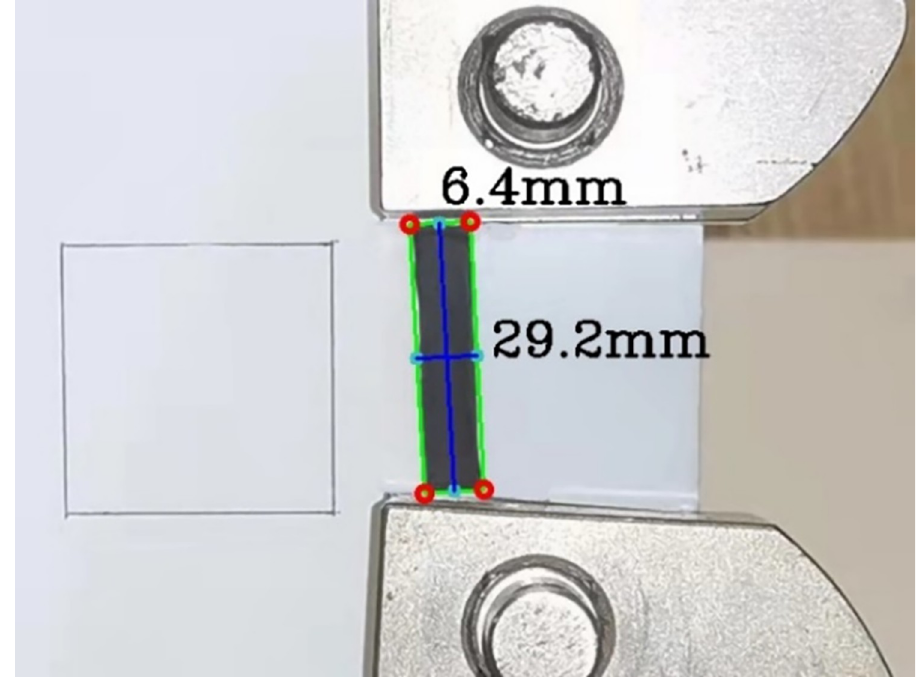
Fig 8. Size calculation.